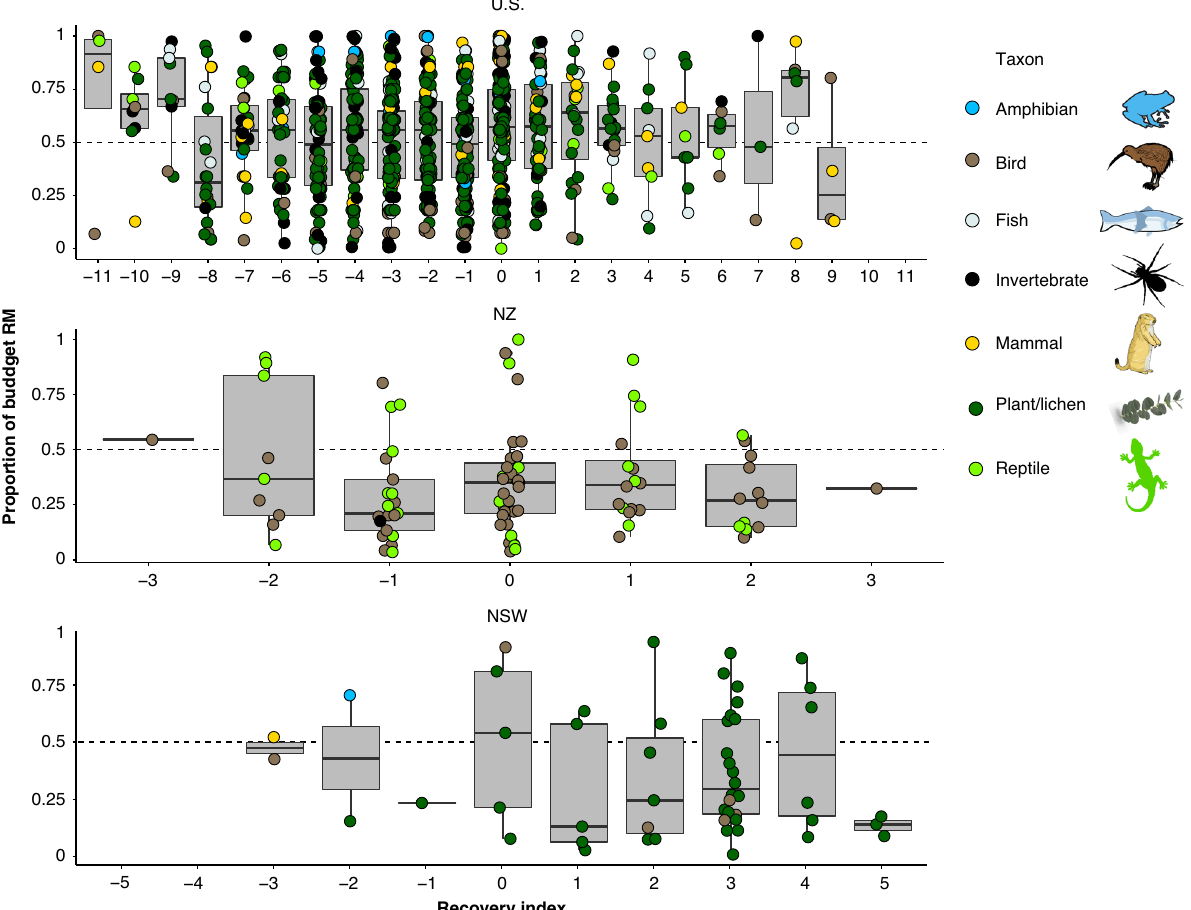
Fig. 3 Species with poor recovery outcomes have a higher proportion of the budget allocated to research and monitoring. The median and range of proportion of recovery plan budgets allocated to research and monitoring (RM) for n = 1143 threatened species in the United States (U.S.), New Zealand (NZ), and New South Wales, Australia (NSW) as a function of index of recovery. The index of recovery is the sum of reports in which population increases ( + 1), decreases ( − 1), or remains constant (0) between assessments, the range for the U.S. is: − 11 to 11, NZ: − 3 to 3, and NSW: − 5 to 5 (although no species had an index of − 5 or − 4). Taxon of each species is indicated by color. For each recovery index, the box and whiskers show the median as a line, fi rst and third quartiles as hinges, and the highest and lowest values within 1.5 times the inter-quartile range as whiskers. All vector graphics are open